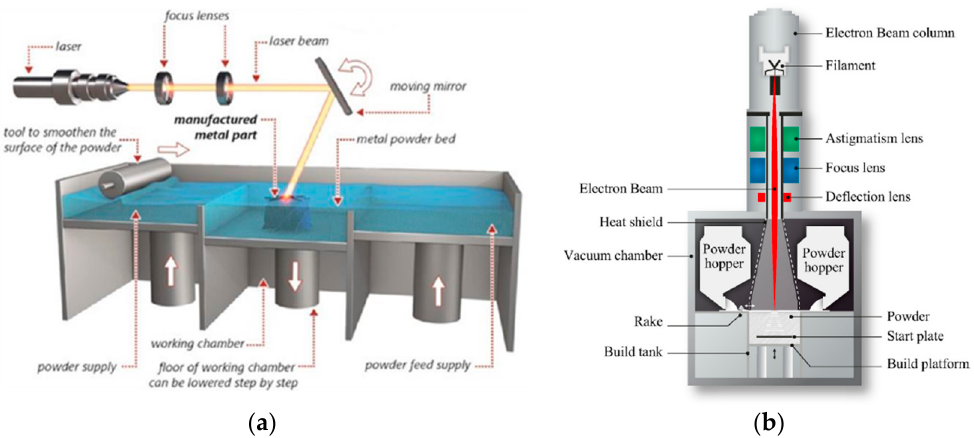
Figure 1. Main components of ( a ) Selective Laser Melting (SLM) machine, ( b ) Electron Beam Melting (EBM) machine. Adapted from [20], under CC BY 4.0. Original sources: ( a ) EMPA, ( b ) ARCAM.